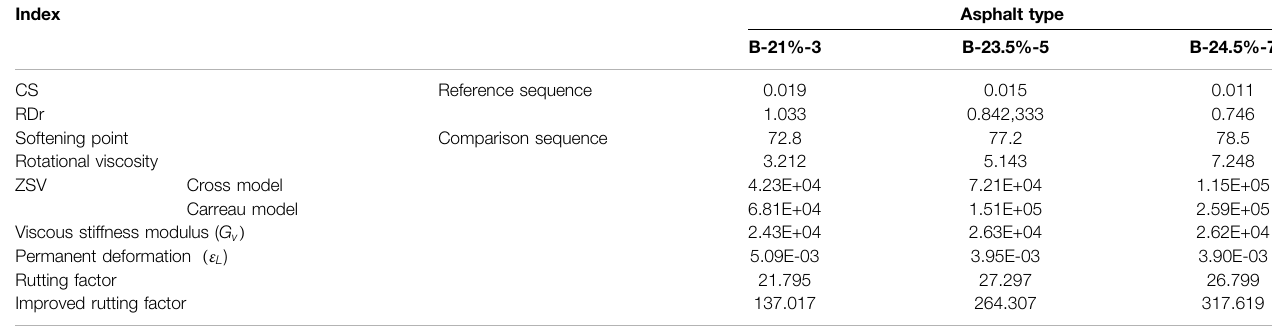
TABLE 8 | Initial values of the reference sequence and comparison sequence.